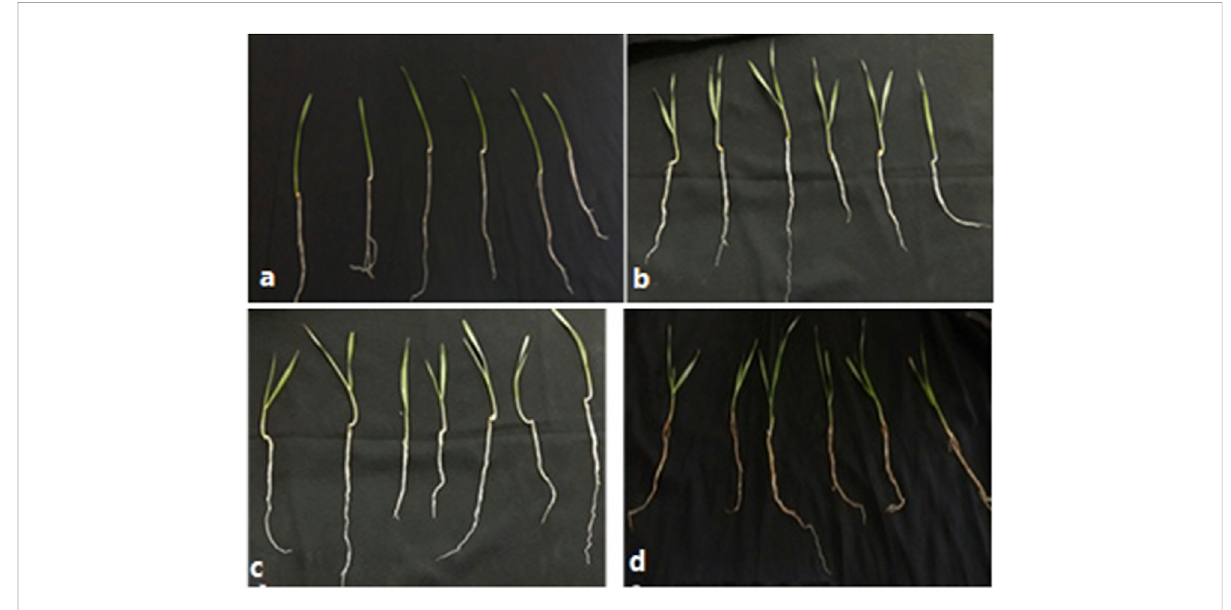
FIGURE 2 Effect of drought stress on leaf pigmentation: (A) control-1 plants [23(0)]; (B) drought-stressed plants [23(7)]; (C) control-2 plants [31(0)]; (D) post-drought recovery plants